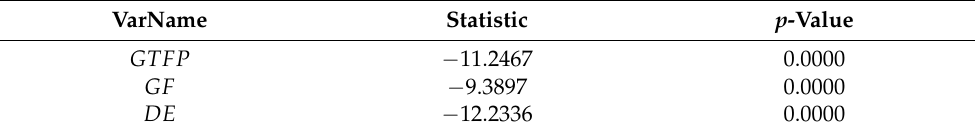
Table 5. LLC test results.